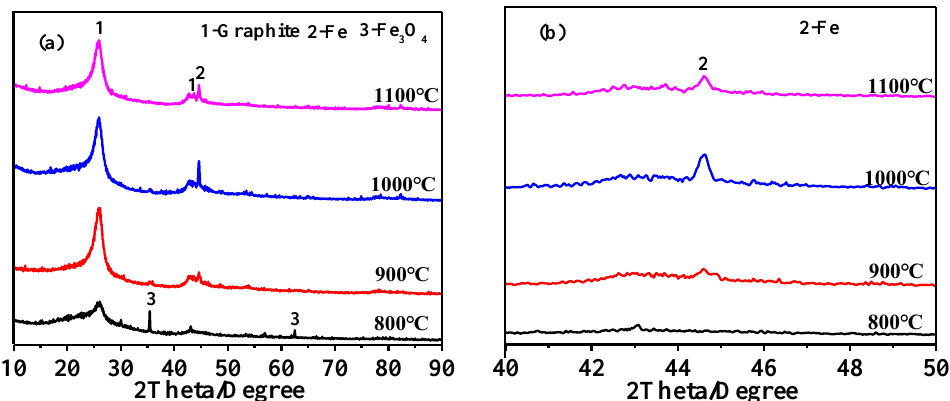
Figure 1. ( a ) XRD patterns of HGCS resulted from 3 h firing of presynthesized carbon spheres with 1.0 wt % Fe at different temperatures and ( b ) magnification of the XRD patterns within 40°–50° (ICDD: 01-075-1621 (Graphite), 01-089-7194 (Fe), and 01-089-0688 (Fe 3 O 4 )).